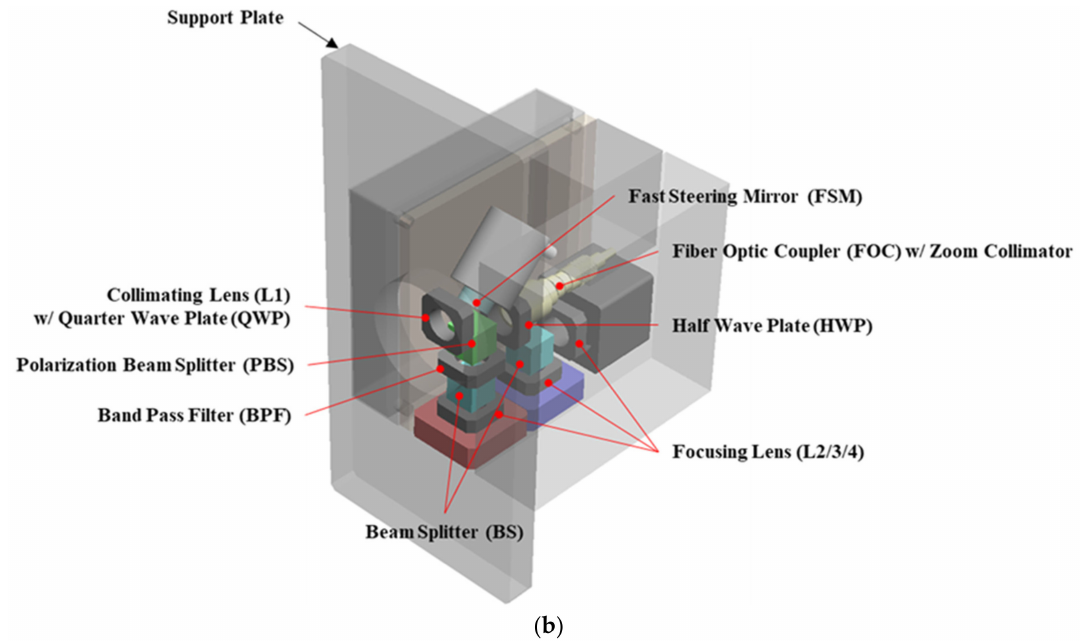
Figure 9. Configurations of the laser communication payload: ( a ) stowed and deployed exterior configurations; ( b ) interior configuration of the optical bench.